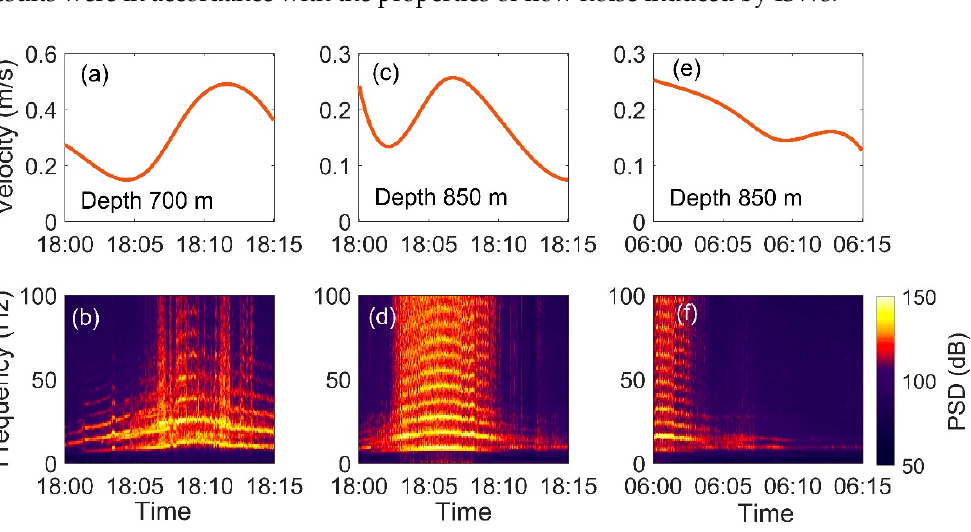
Figure 5. Flow velocities and time–frequency spectra (dB) of the C058 hydrophone (700 m) on ( a , b ) 14 March 2017. Flow velocities and time–frequency spectra of the C010 hydrophone (950 m) on ( c , d ) 1 October 2016 and ( e , f ) 21 September 2016. The depth on the figures represents the depth at which the flow velocity was measured.